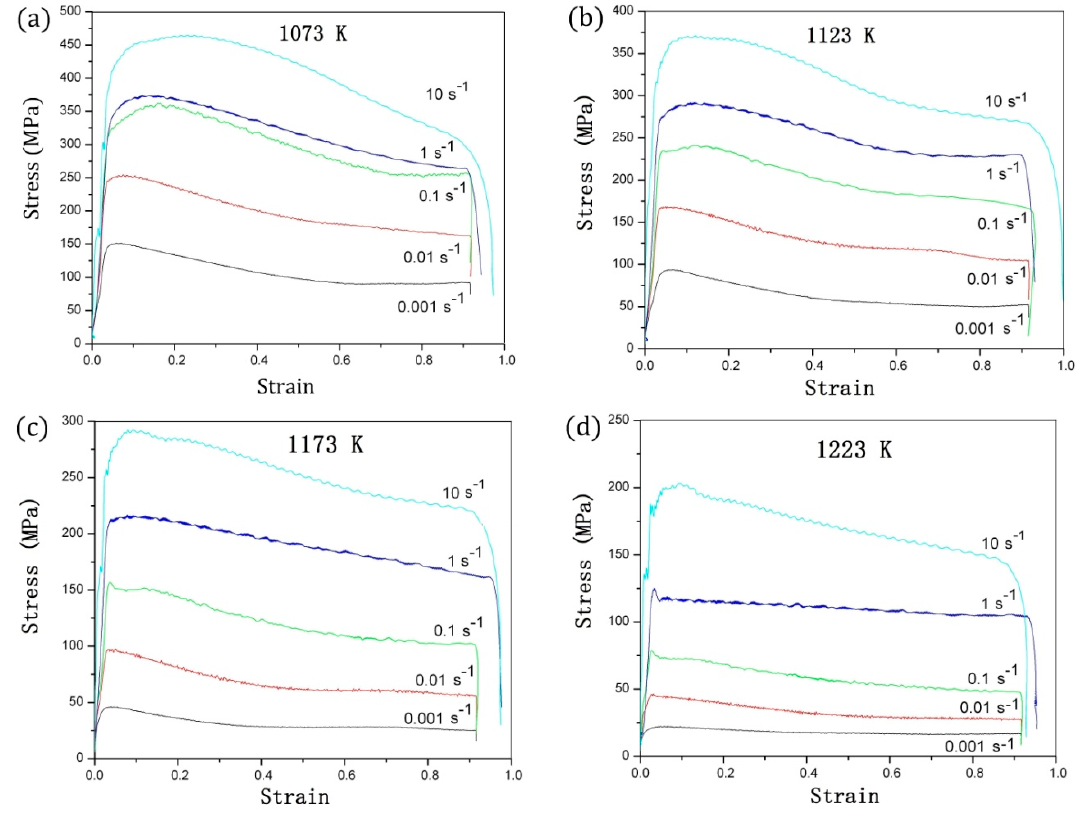
Figure 3. True stress versus true strain curves of TA15 titanium alloy obtained by isothermal hot compression tests at temperatures of: ( a ) 1073 K, ( b ) 1123 K, ( c ) 1173 K, and ( d ) 1223 K.